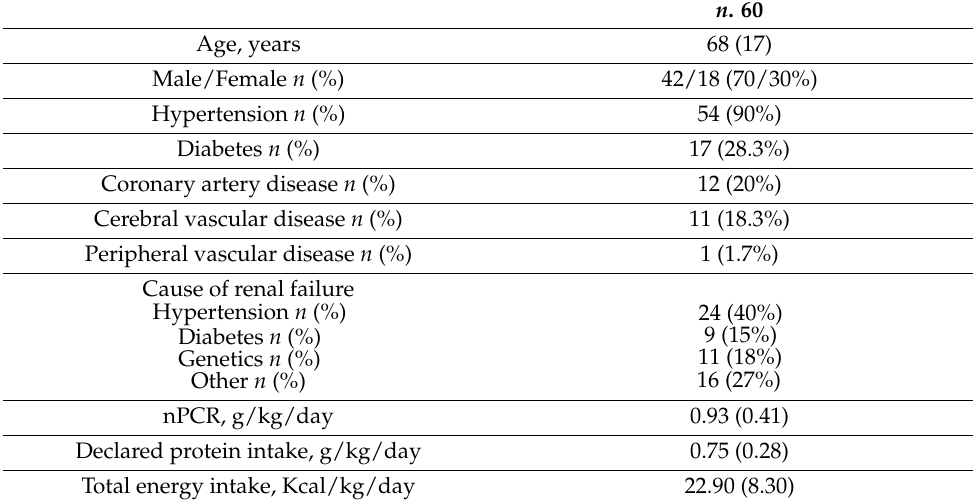
Table 1. Characteristics of